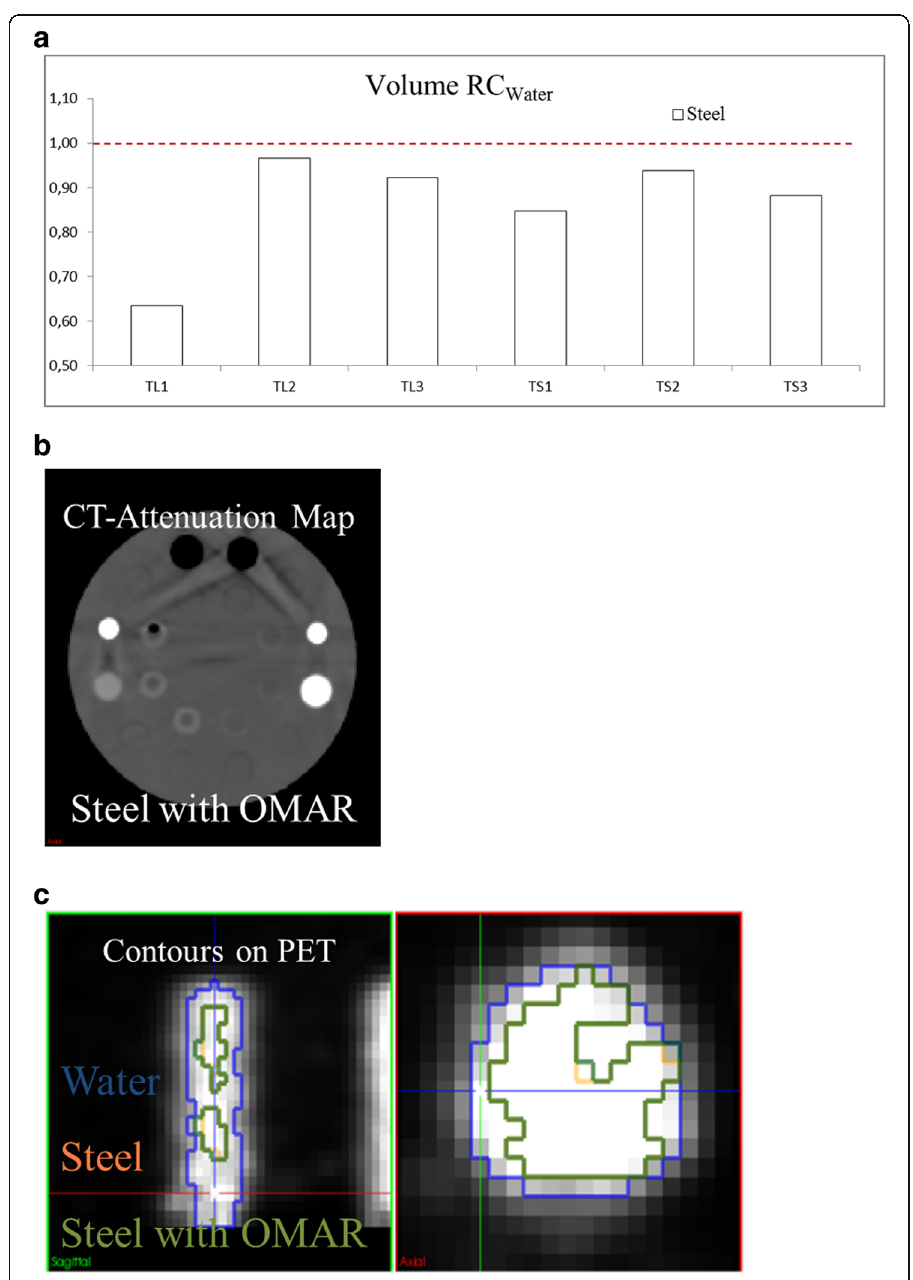
Fig. 6 Cheese-Phantom in prostate configuration with steel inserts. a Recovery coefficients with respect to water (RC water ) for the radiotracer fillable tubes. b CT attenuation maps and c PET contours for tube